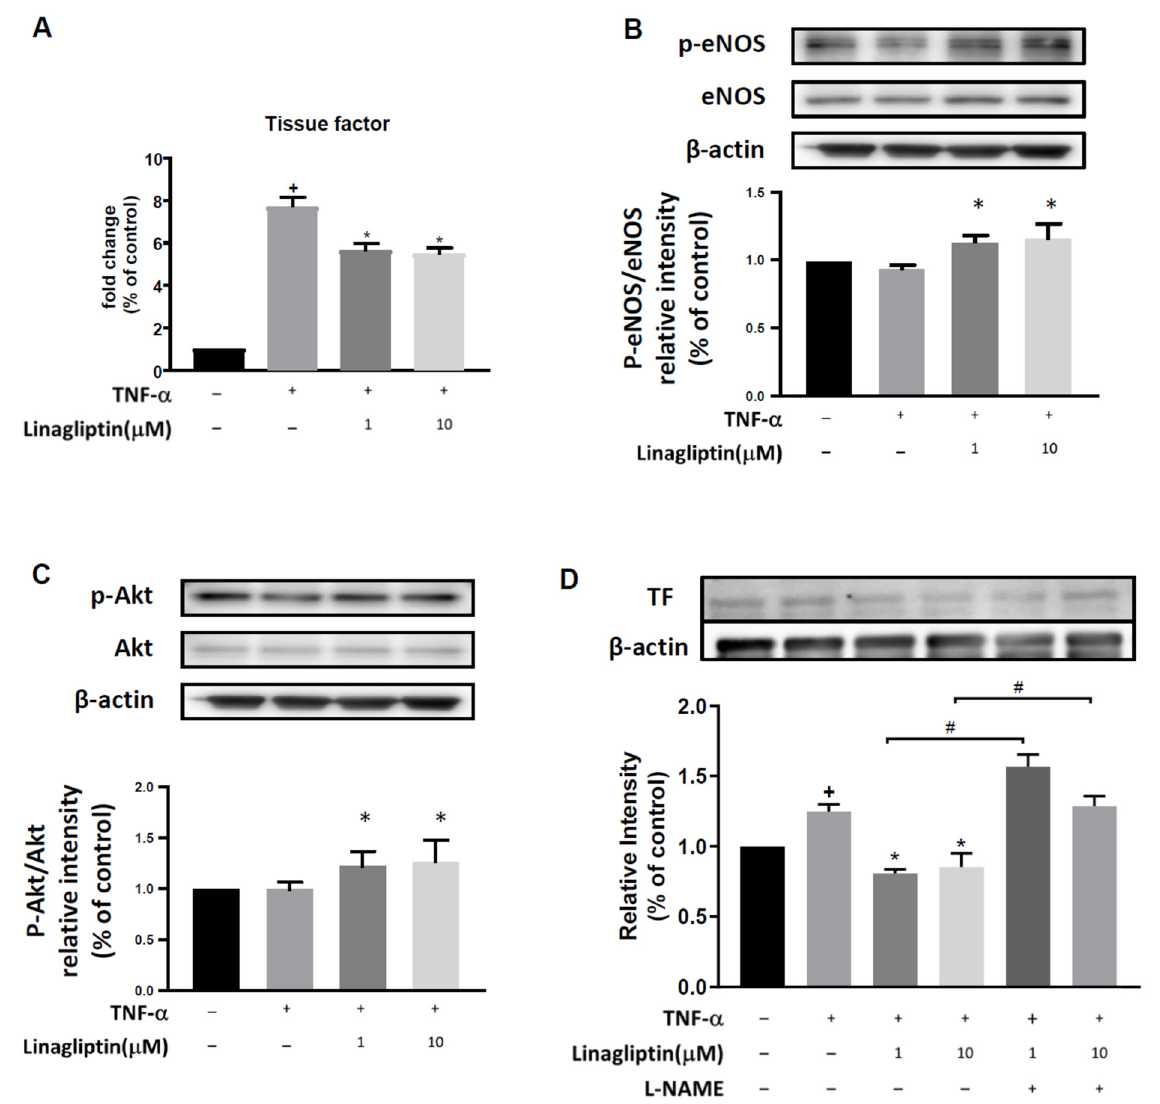
Figure 2. Linagliptin suppresses TNF- α -induced tissue factor expression via an Akt/eNOS pathway. HUVECs were pretreated with different doses (1 and 10 µ M) of linagliptin for 48h and then incubated with 0.5 ng TNF- α for 2h. Gene expression and protein levels were detected by qPCR and western blot. ( A ) Expression levels of tissue factor (TF). ( B ) Phosphorylation ratio of eNOS. ( C ) Phosphorylation ratio of Akt. ( D ) Protein levels of TF with or without L-NAME pretreatment, an eNOS inhibitor. n = 6 in each group. + p ≤ 0.05 compared to respective control. * p ≤ 0.05 compared to TNF- α -treated cells. # p ≤ 0.05 compared to TNF-a plus linagliptin-treated group.